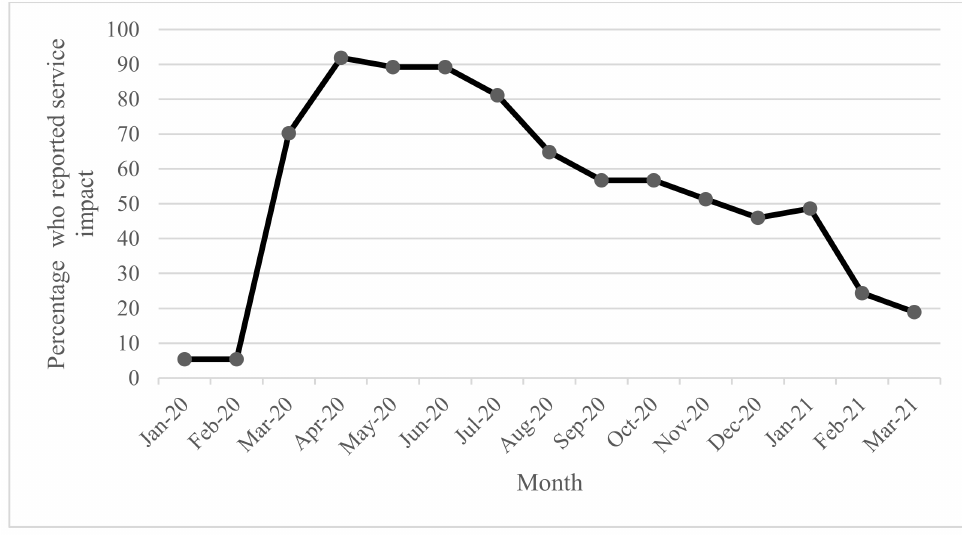
Figure 3. Percentage of responses that reported AT service impacts due to COVID-19 each month